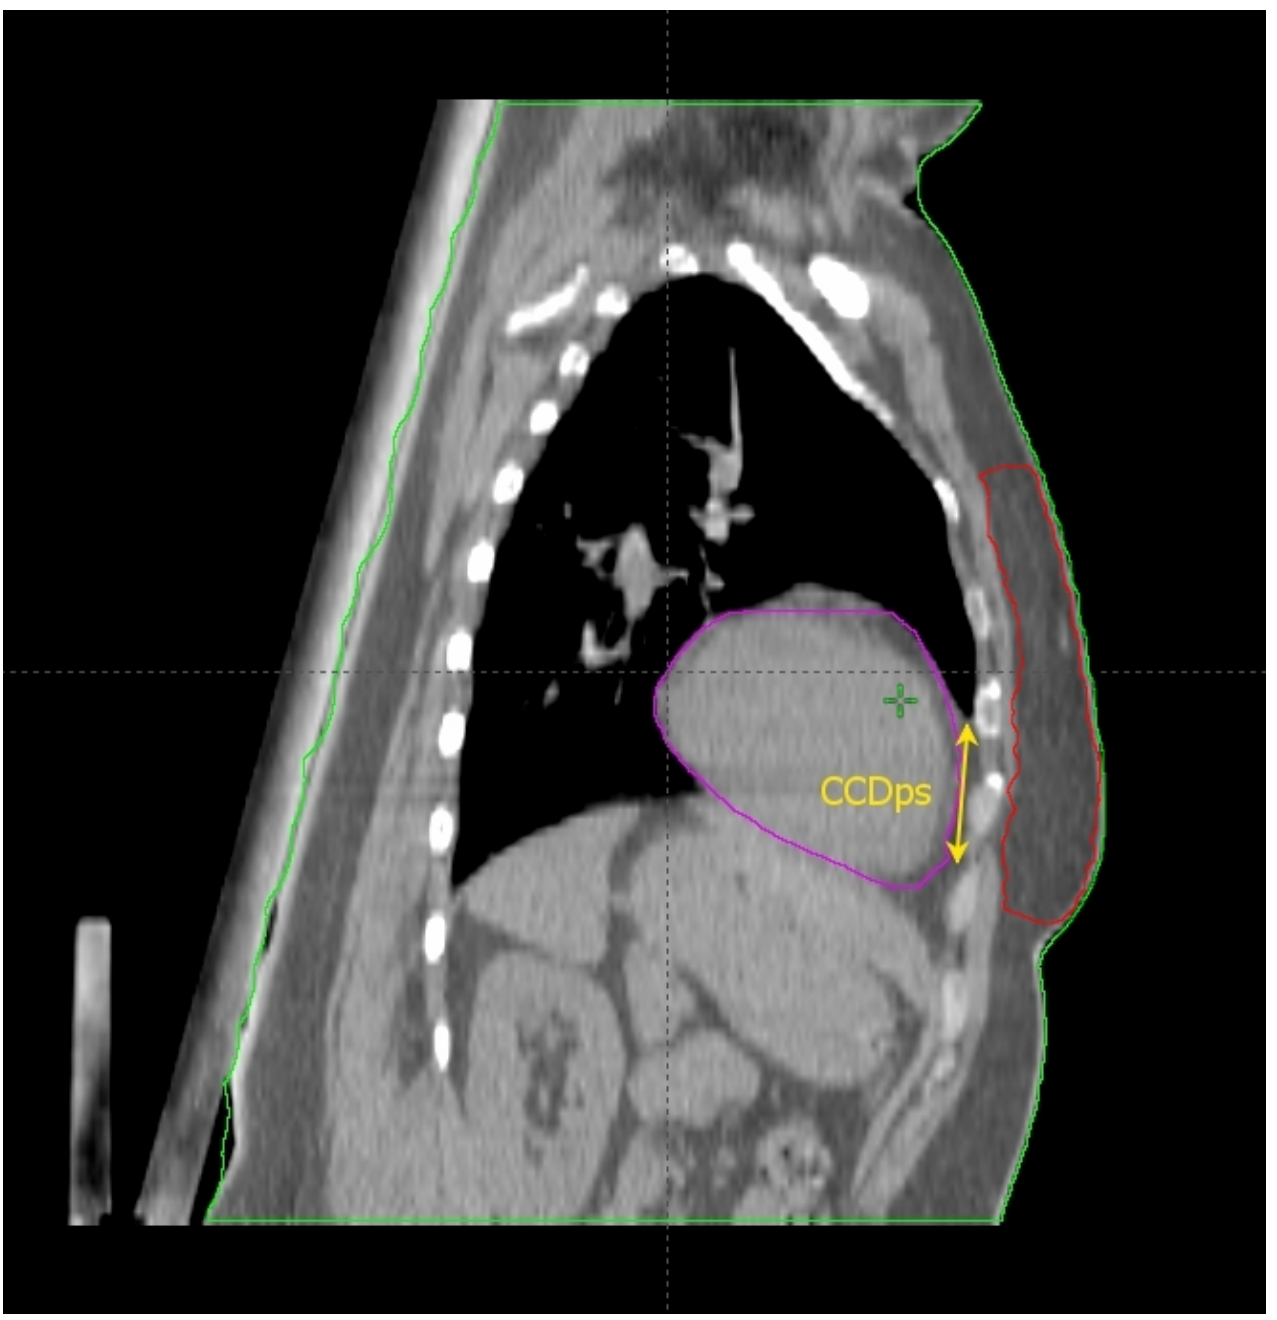
Figure 2. Anatomical parameters on the parasagittal CT plane, chosen as described in the text.